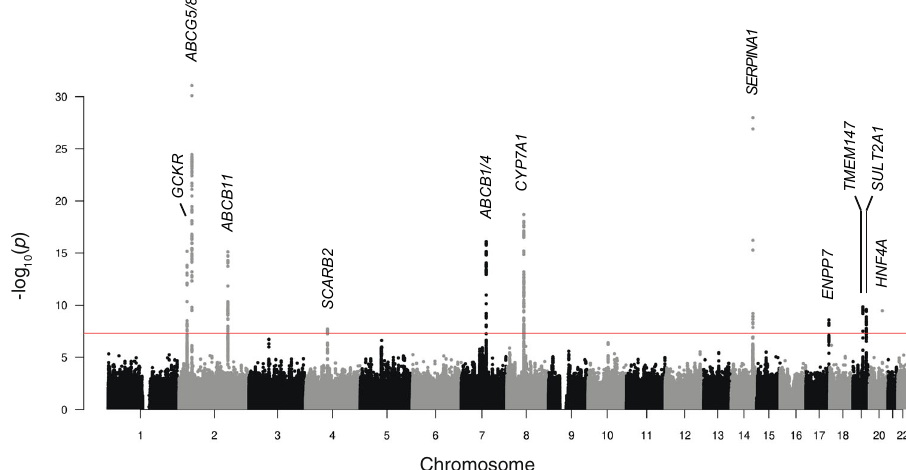
Fig. 1 Manhattan plot for the genome-wide association study meta-analysis of intrahepatic cholestasis of pregnancy (ICP). Data shown are from the combined meta-analysis including 1138 cases and 153,642 controls, all of European ancestry. The chromosomes are ordered on the x axis; the y axis shows the − log 10 ( P ) values for the association tests. Eleven loci achieved genome-wide signi fi cance ( P < 5 × 10 − 8 , indicated by the red line). The prioritized gene at each locus is shown. The effector gene functional prioritization strategy followed in this study is presented in Fig. 2. Association testing was performed using a generalized logistic mixed model to account for population strati fi cation and saddle-point approximation to control for type 1 error rates due to unbalanced case – control ratios, followed by meta-analysis weighting the effect size estimates using the inverse of the standard errors.